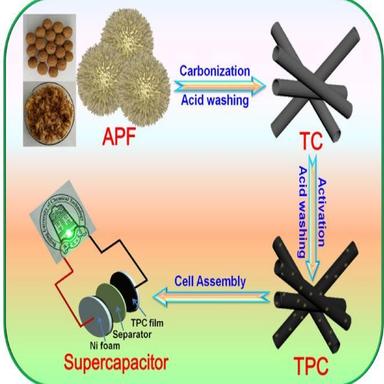
Schematic illustrations of the preparation of TPC from the APF.